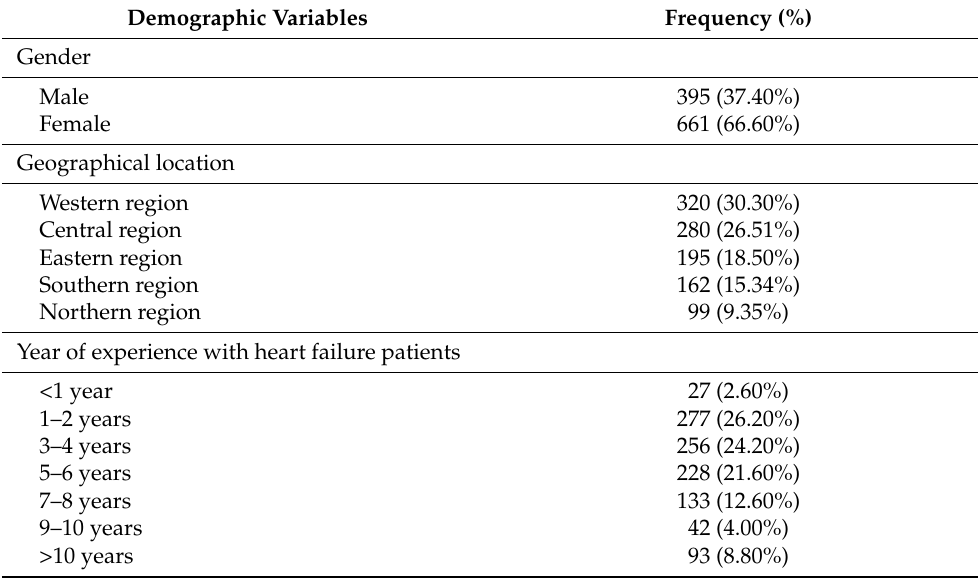
Table 1. Demographic data and characteristics of study respondents ( n =